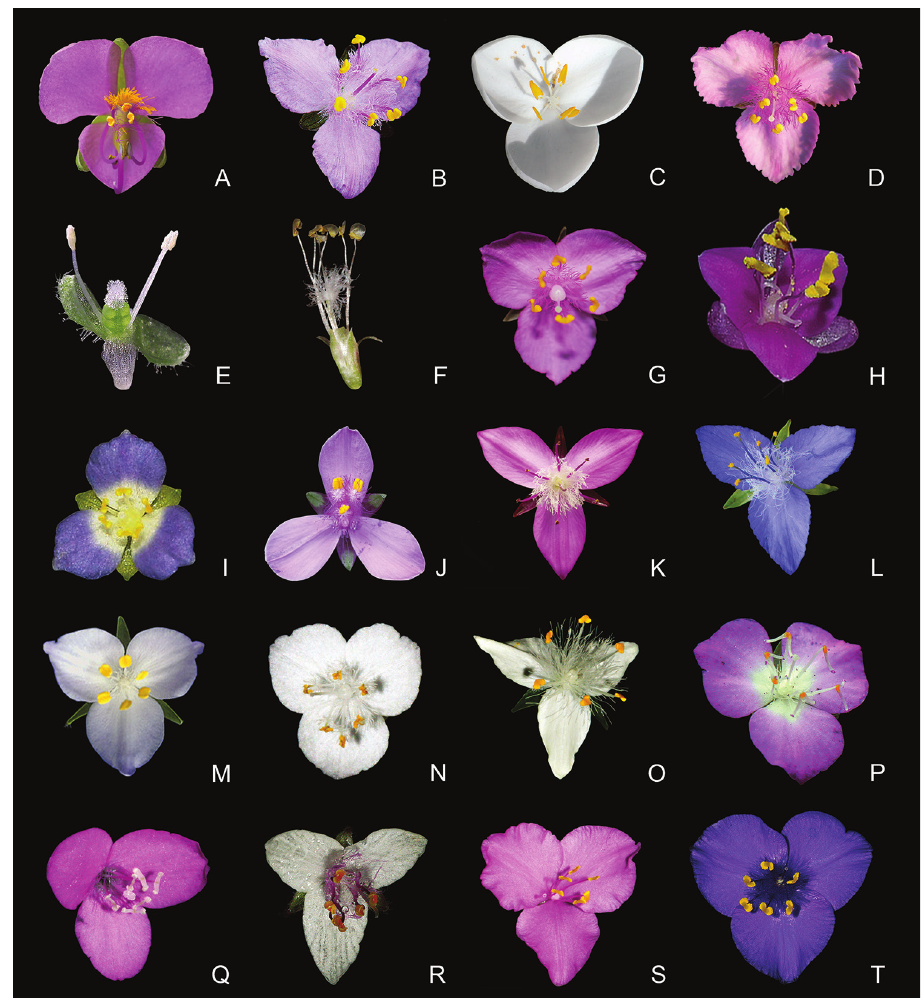
Figure 6. Floral morphology of subtribe Tradescantiinae s.l. A Tinantia Scheidw B Thyrsanthemum Pichon C Weldenia Schult.f. D–I Callisia Loefl. s.l. : D Cuthbertia Small E Aploleia Raf. (i.e. C. sect. Leptocallisia s.s. ) F Callisia s.s. (i.e. C. sect. Callisia ) G Callisia sect. Brachyphylla D.R.Hunt H Hadrode- mas H.E.Moore (i.e. C. sect. Hadrodemas ) I–J Tripogandra Raf. s.l. : I Callisia sect. Leptocallisia pro